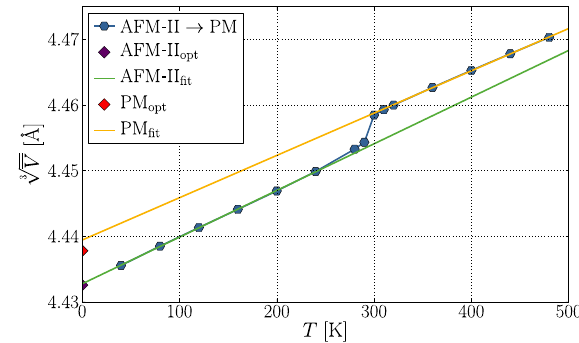
Fig. 5 Thermal expansion of MnO. Cube root of the mean volume ffiffiffi p V 3 per unit cell as a function of the temperature T obtained in 10 ns NpT MD simulations including MC spin fl ips of 6 × 6 × 6 MnO supercells and the optimized values at p = 1 bar of the AFM-II and PM con fi gurations. The straight lines represent linear fi ts for the high- and low-temperature